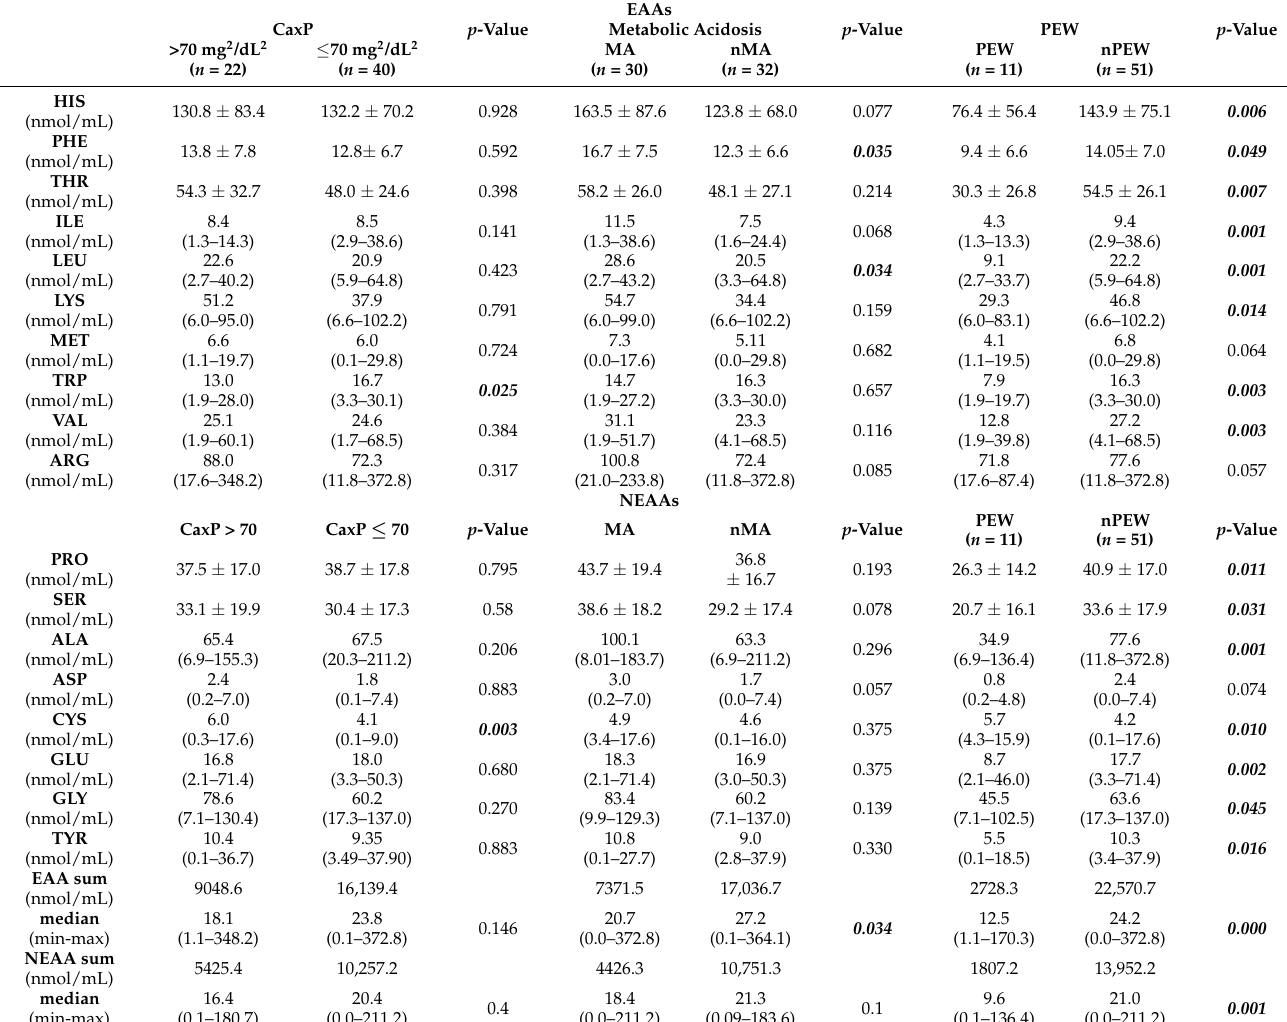
Table 3. T -test and Mann–Whitney comparison of serum amino between dogs with